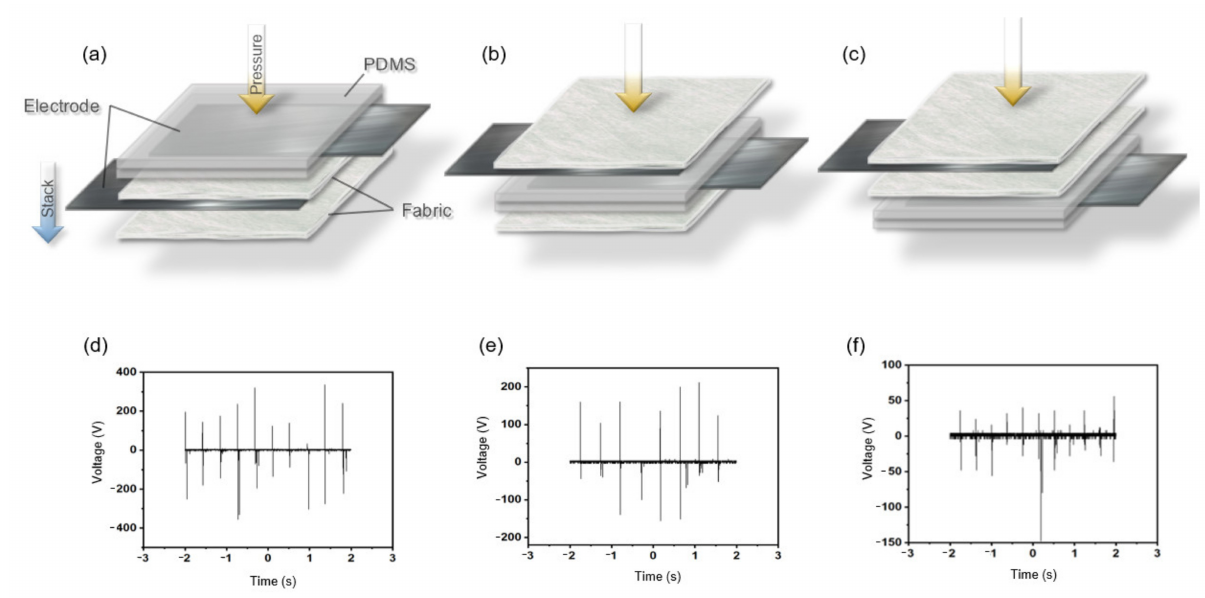
Figure 7. Schematic of the FTENGs with the PDMS layer positioned ( a ) at the top, (b) in the middle, and ( c ) at the bottom. Output voltage of the FTENGs with the PDMS layer ( d ) at the top, ( e ) in the middle, and ( f ) at the